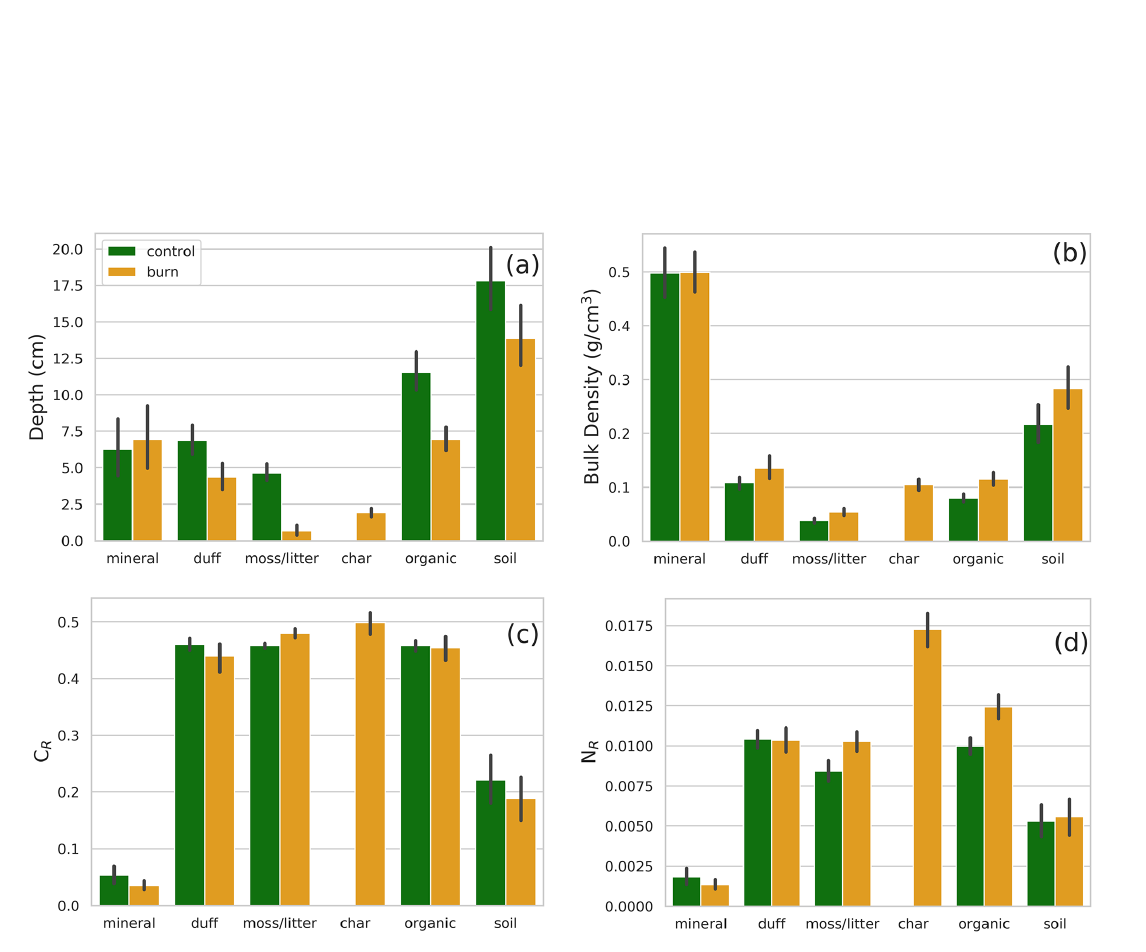
Figure 4. Mean soil compartment depths (a) , bulk density (b) , C R (c) , and N R (d) in burnt and control plots. The organic category is considered the grouping of the duff, moss/litter, and char layers while the soil category is the grouping of the organic and mineral soil layers. Error bars are the bootstrapped 95% confidence interval of the